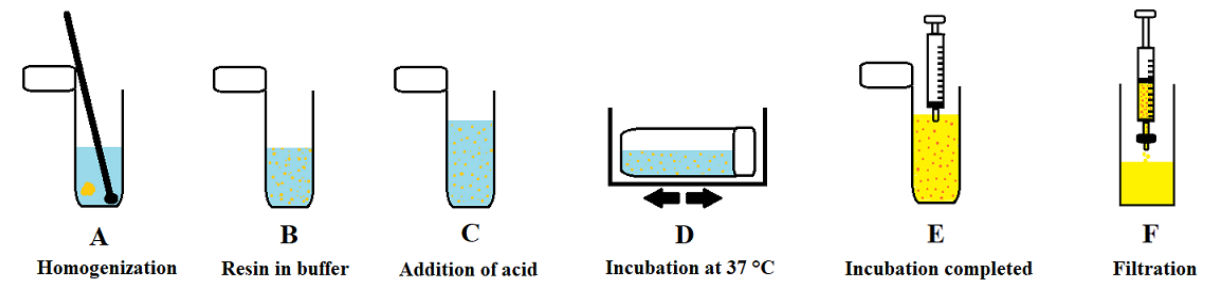
Figure 1. On-resin enzyme testing. All fluorescence data were obtained in three independent parallels, while for each individual set of measurements, an average value as well as the standard deviation were calculated and are graphically